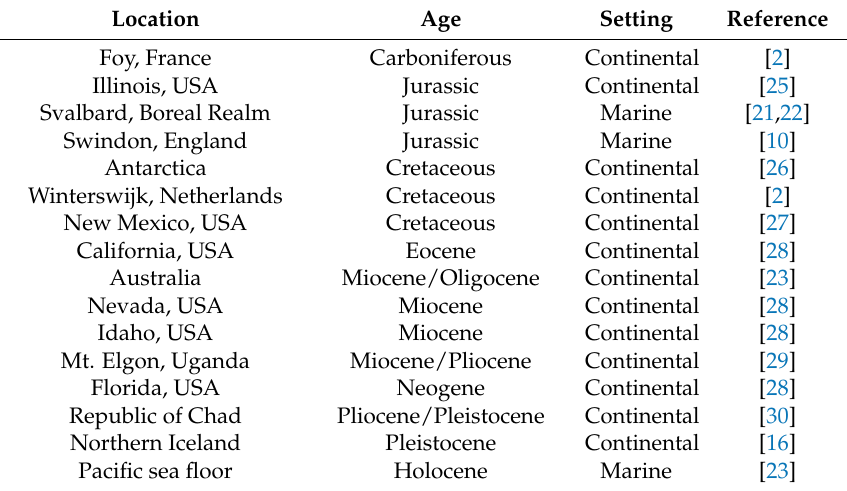
Table 3. Phosphatized wood